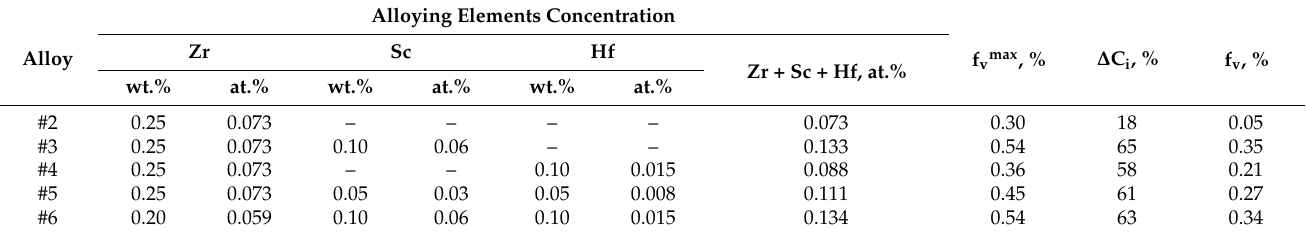
Table 3. Analysis of the parameters of the particles that were nucleating in the investigated